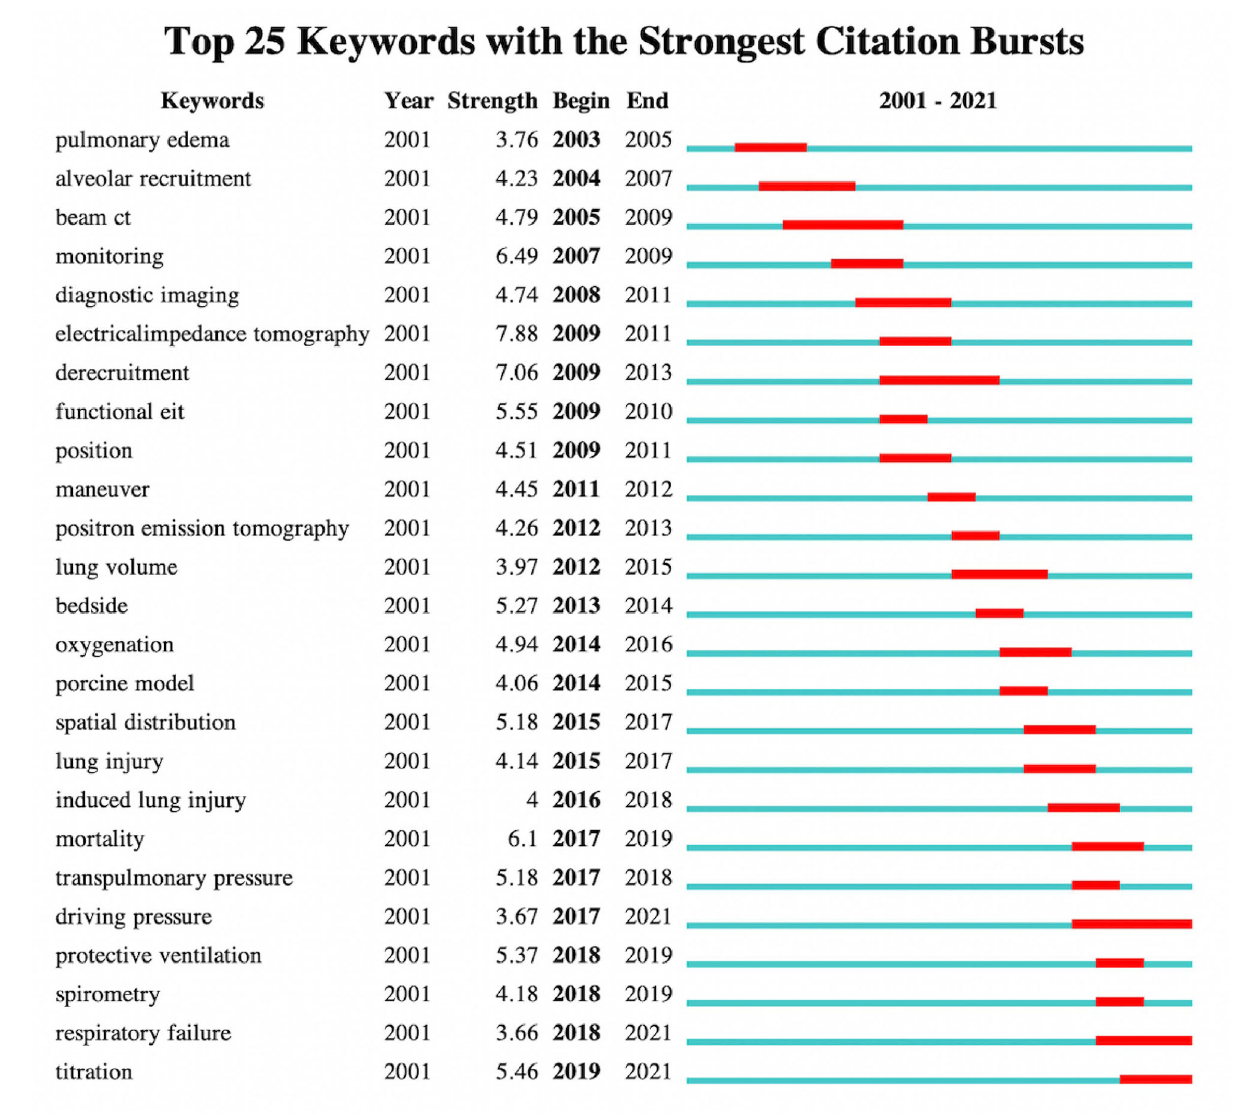
FIGURE 4 | The top 25 keywords with the strongest burst value on EIT applications in clinical lung monitoring research from 2001 to May 29, 2021. The dark blue bar showed that the years in which keywords received slight increases in co-occurrence, the red bar indicates that co-occurrence rose sharply.